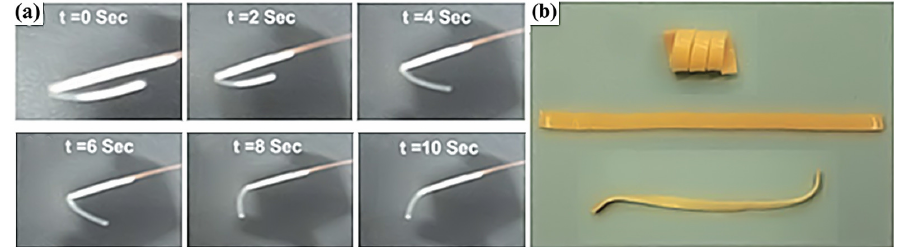
Figure 5. ( a ) Shape recovery of the photoinduced shape memory polymer material [67]. ( b ) Deforma- tion process of photothermal shape memory polymer materials